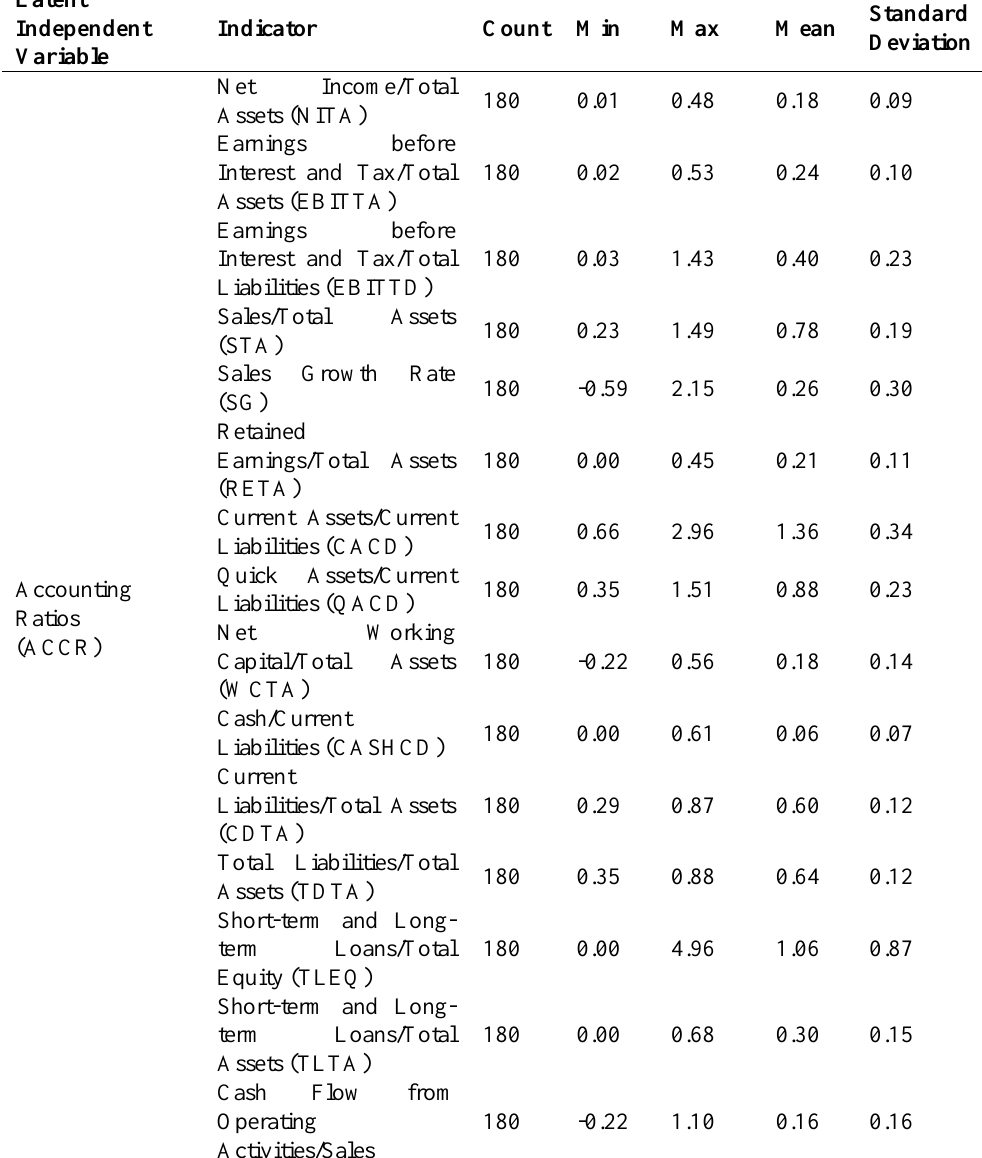
Table (9). Descriptive Statistics for Indicators of Latent Independent